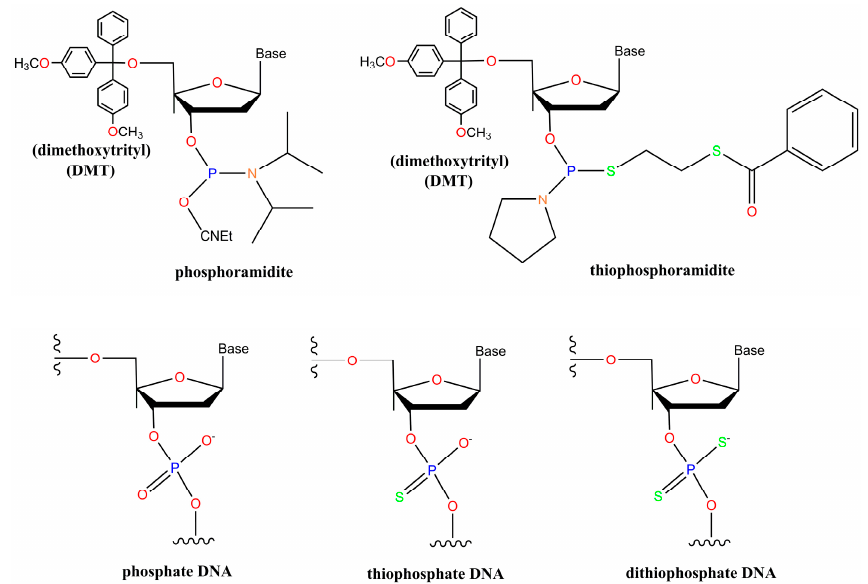
Figure 2. Structures of DNA synthesis reagents and DNA containing normal DNA backbones or thioated DNA backbones.